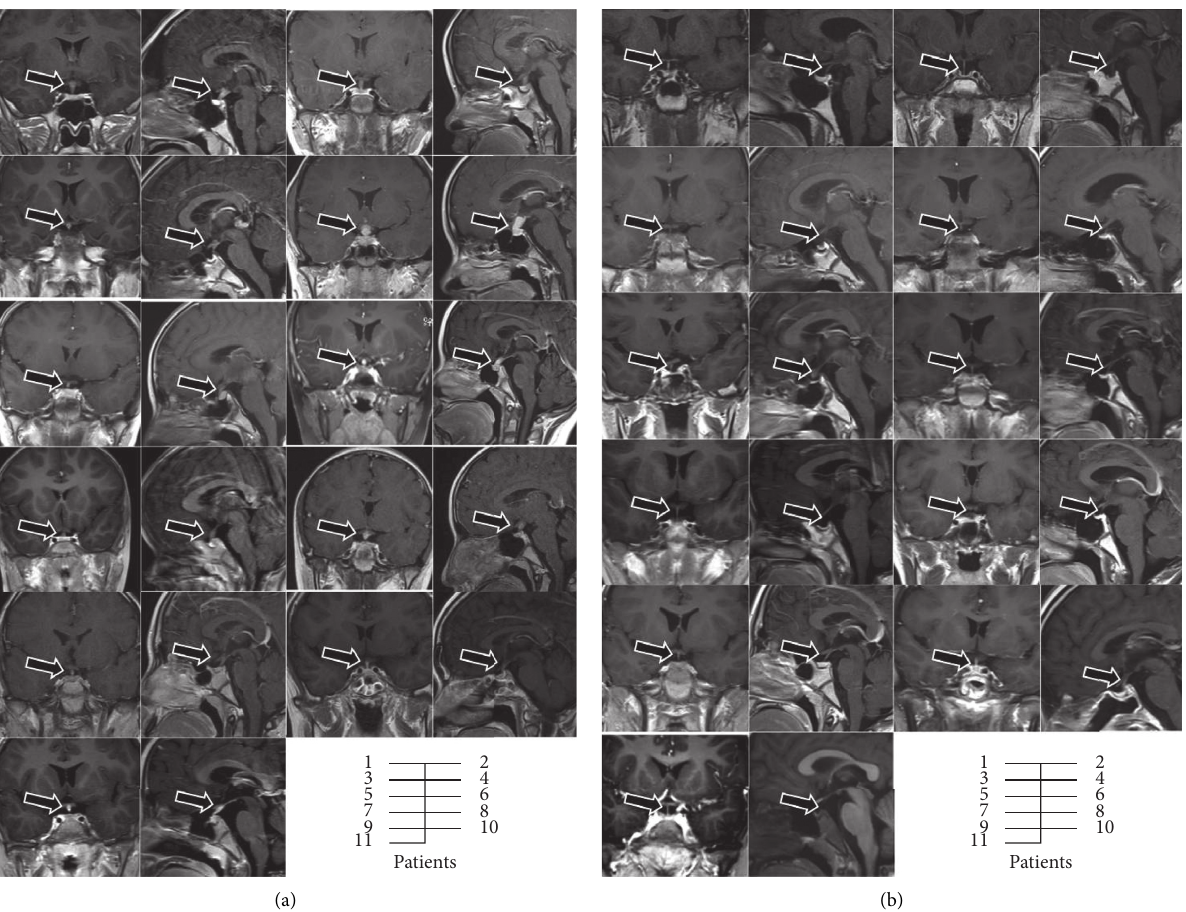
Figure 1: Contrast-enhanced brain magnetic resonance imaging of patients: (a) coronal/sagittal-enhanced brain magnetic resonance imaging at diagnosis and (b) coronal/sagittal-enhanced brain magnetic resonance imaging after chemoradiotherapy (tumor is marked with the arrow). Table 2: Neuroendocrine disturbance of the